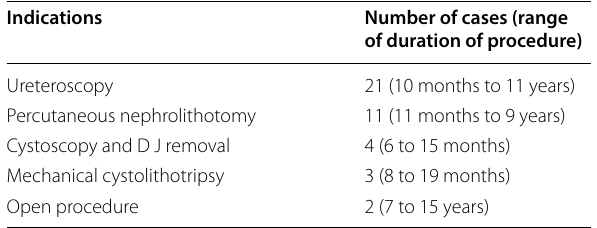
Table 3 Procedures performed for removal of D J stent Indications